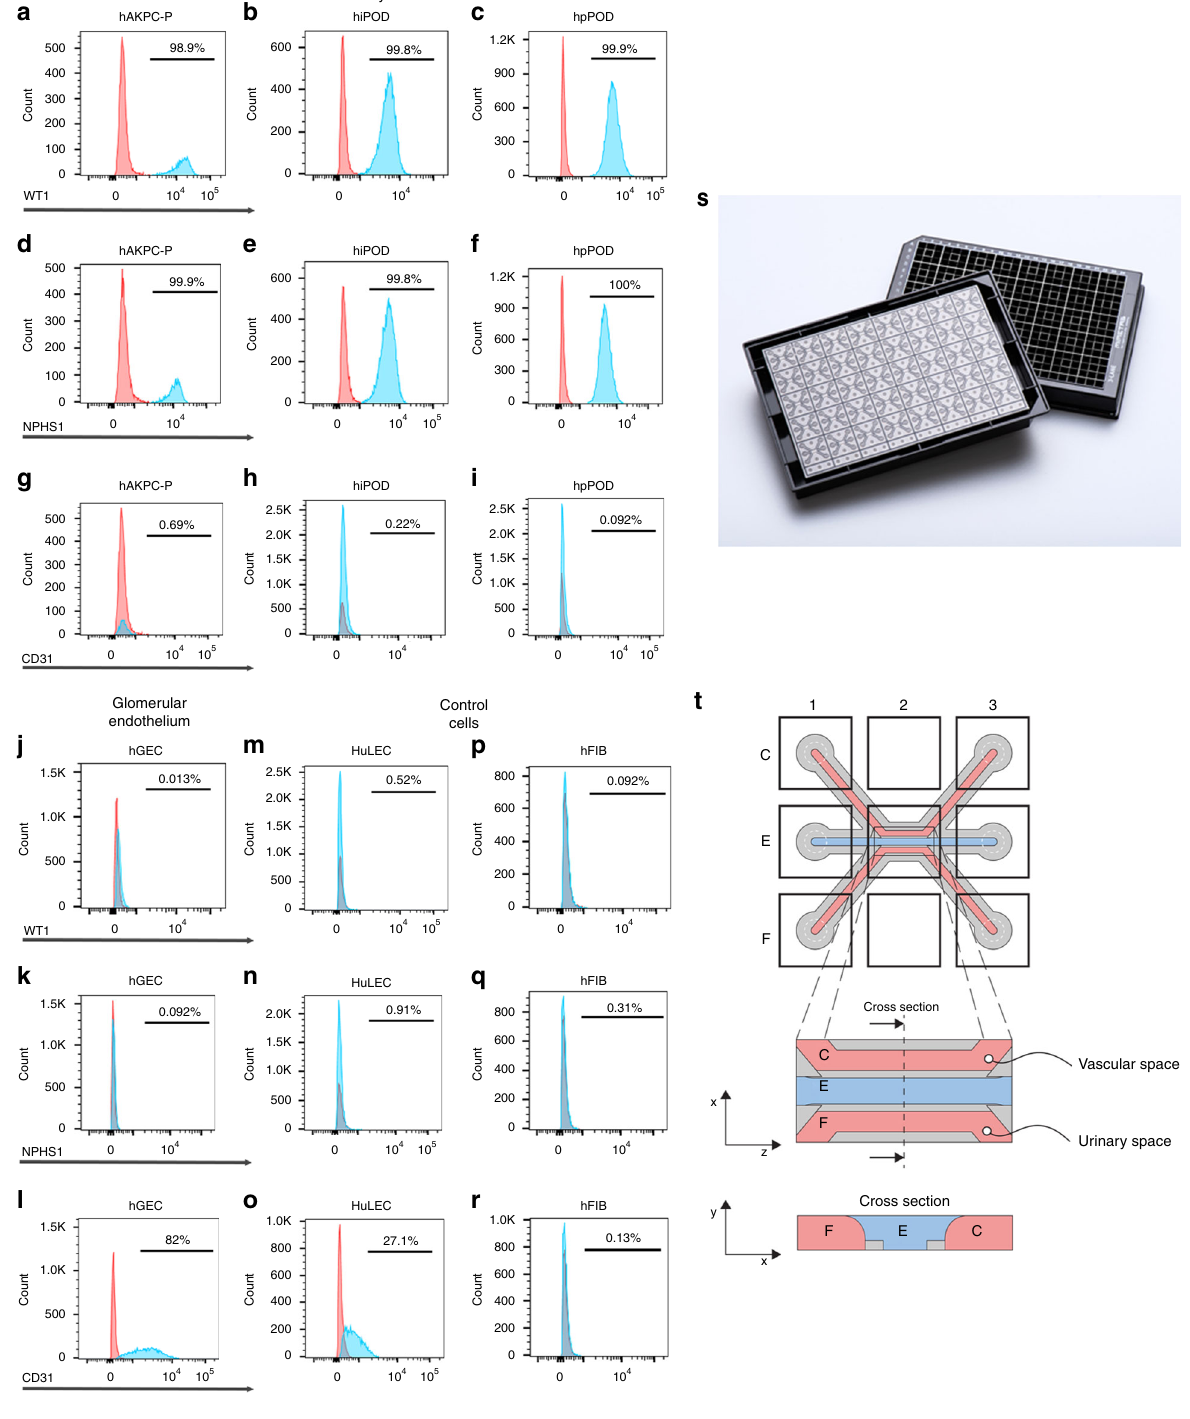
and the collagen. Therefore, the interaction of the layers of seeded cells (channel C) and matrix recapitulates the in vivo GFB oriented from endothelial cells, the GBM, podocytes, and the urinary space of Bowman ’ s capsule (channel F). hGEC were seeded in channel C (Fig. 2a) and cultured in endothelial med- ium. We con fi rmed their ability to form a capillary-like structure in the chip (Fig. 2b) and maintain expression of endothelial marker CD31 (Fig. 2c). Presence of an endothelial glycocalyx on the surface was also con fi rmed by immuno fl uorescent staining